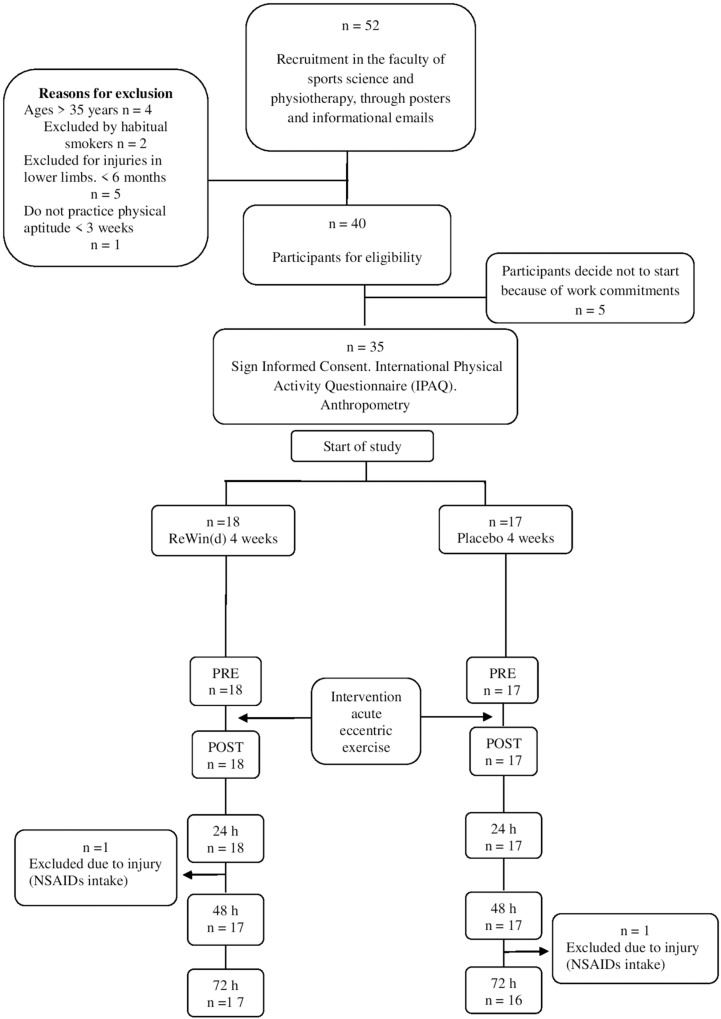
Study flow chart.